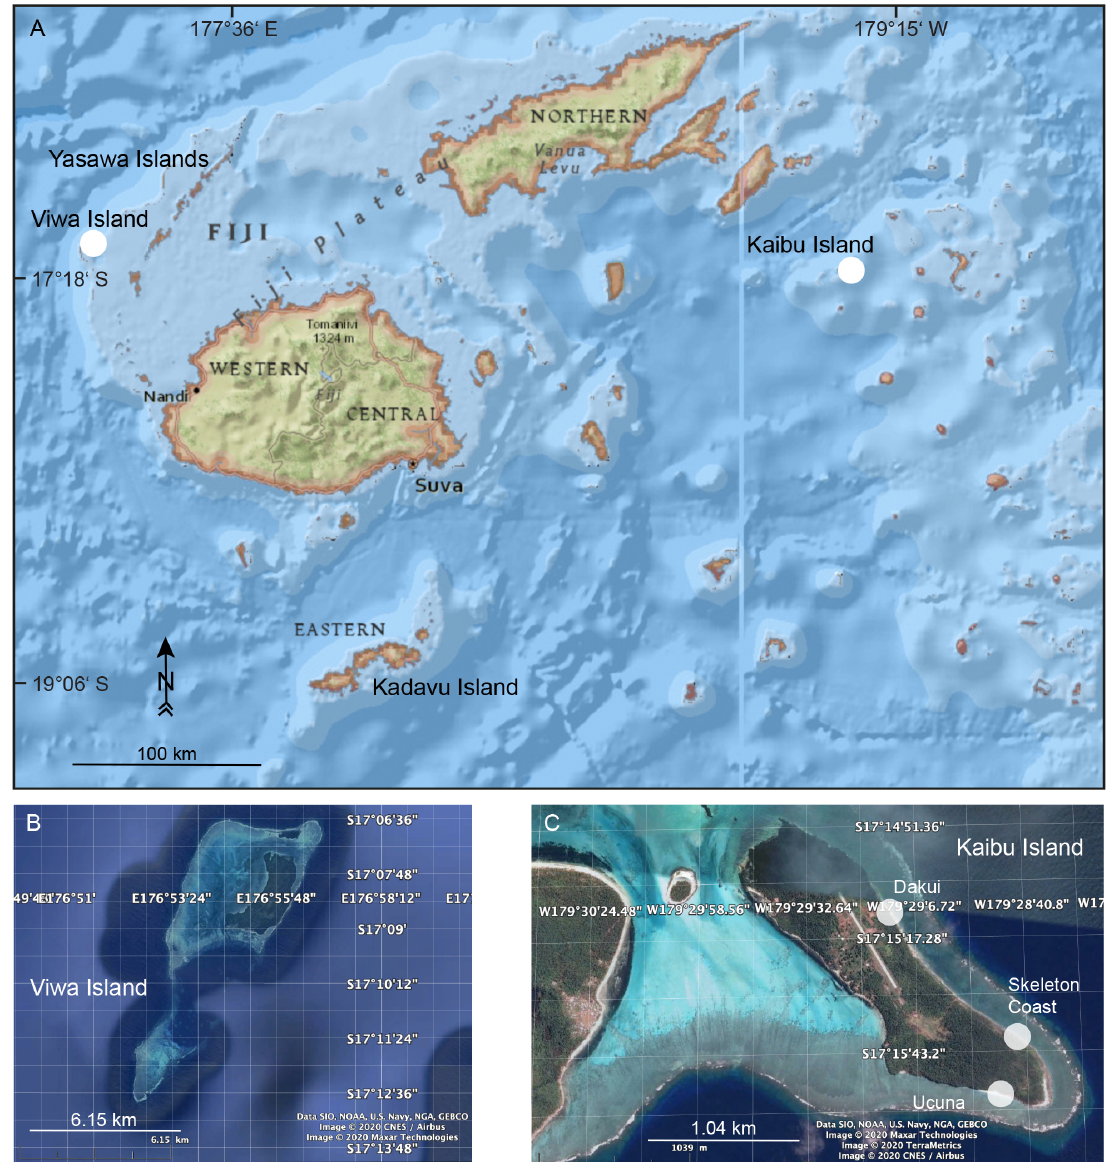
Figure 7. Map showing islands in Fiji considered in this article (white circles). Study sites on Kaibu Island are indicated by white circles. Basemap: “National Geographic Map”, with data from National Geographic, Esri, Garmin, HERE, UNEP-WCMC, USGS, NASA, ESA, METI, NRCAN, GEBCO, NOAA and INCREMENT P Corp (a) . © Google Earth 2020 (b–c)